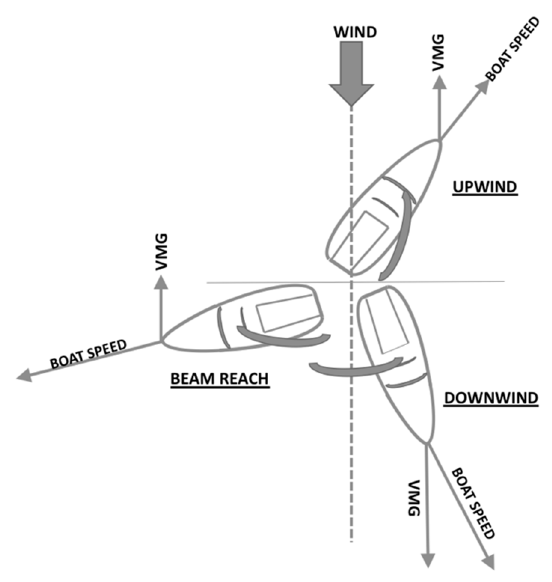
Figure 3. Velocity made good (VMG).